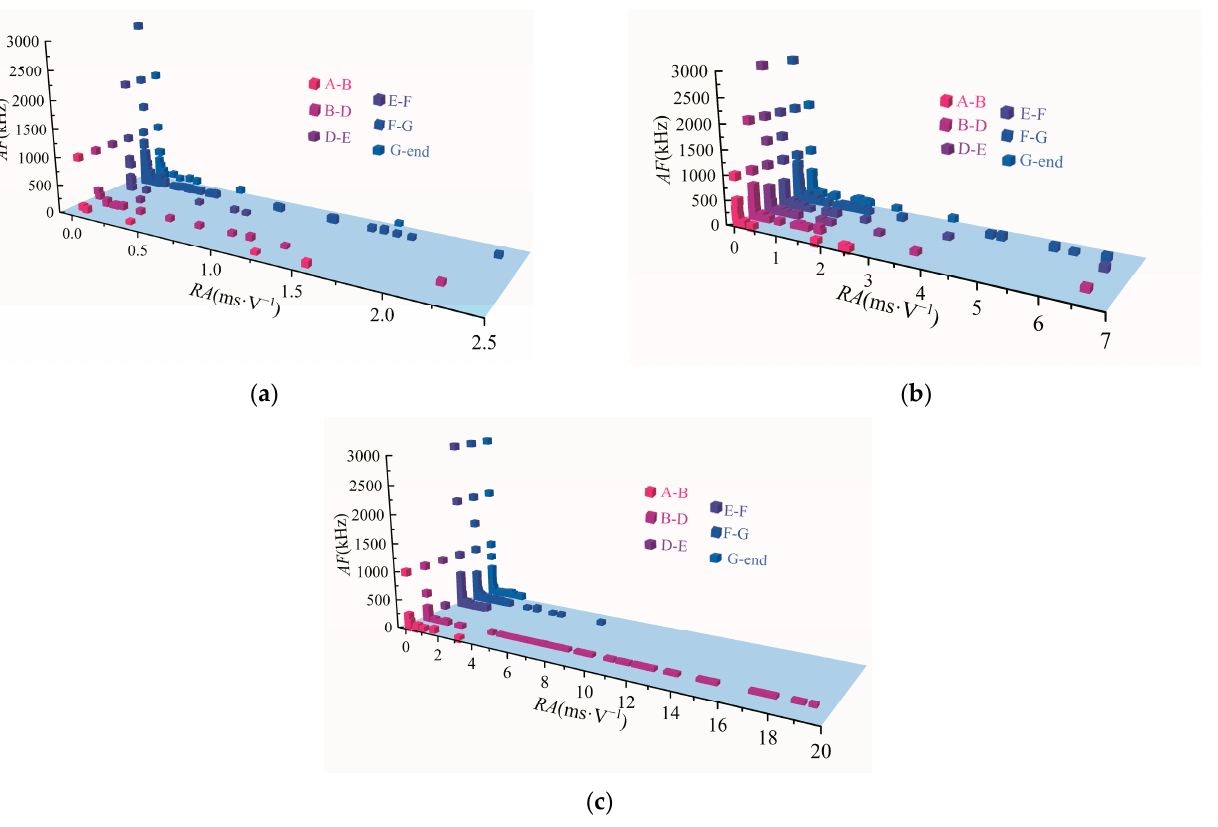
Figure 12. RA–AF distributions in different damaged sections of diorite under variable unloading confining-pressure rates: ( a ) 0.008 MPa·s − 1 , ( b ) 0.016 MPa·s − 1 , and ( c ) 0.032 MPa·s − 1 . confining-pressure rates: ( a ) 0.008 MPa · s − 1 , ( b ) 0.016 MPa · s − 1 , and ( c ) 0.032 MPa · s − 1 .